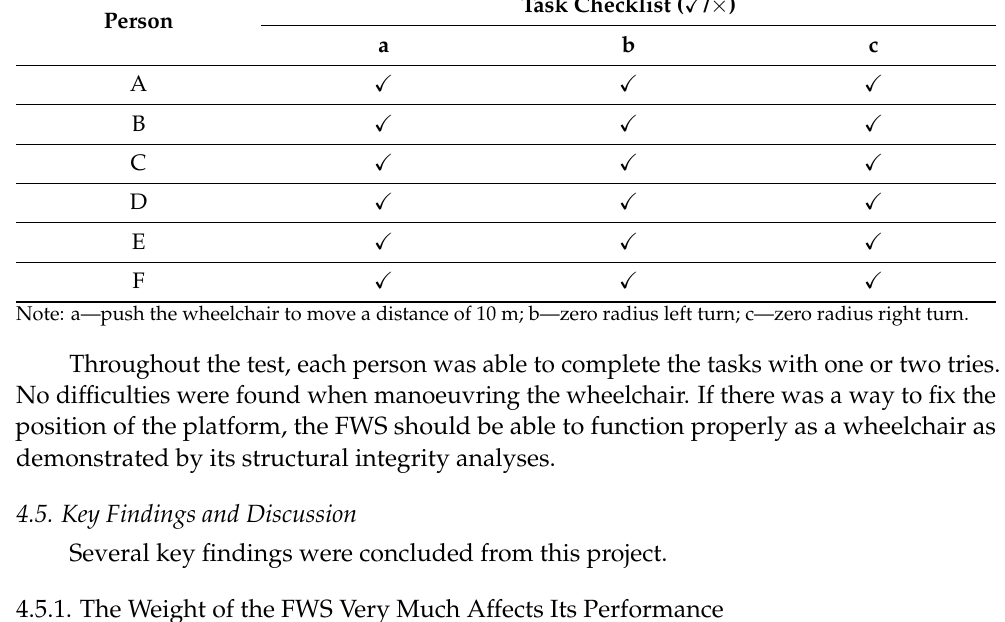
Table 16. Checklist for the wheelchair function test.